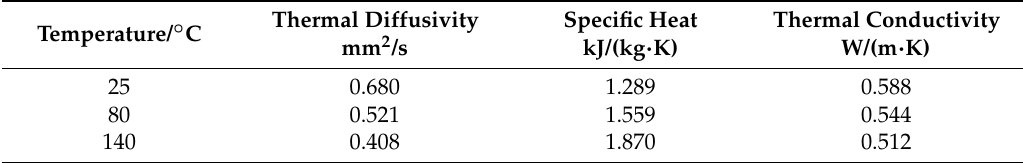
Table 3. Thermophysical properties of polyamide-titanium